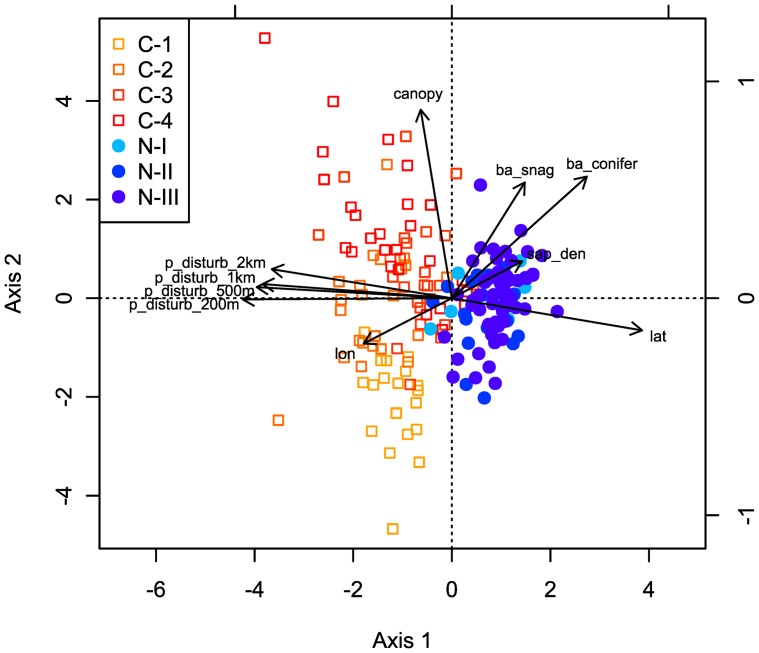
The positions of sampling sites in a constrained ordination space characterised by environmental variables.An arrow's length and its angle represent the strength of the correlation between the corresponding environmental variable and the first two ordination axes. The first axis of the constrained ordination diagram showed latitudinal transition of landscape-level disturbance gradients, and the second axis showed differences in canopy cover across successional gradient in post-clearcutting environment. Environmental variables: lon: longitude, lat: latitude, ba_conifer: basal area of conifer, canopy: canopy cover, sap_den: sapling density, ba_snag: basal area of snag, p_disturb_200 m: proportion of disturbed area at 200 m, p_disturb_500 m: proportion of disturbed area at 500 m, p_disturb_1 km: proportion of disturbed area at 1 km, p_disturb_2 km: proportion of disturbed area at 2 km. Age classes: C-1, C-2, C-3, and C-4: 5–19, 20–39, 40–59, and 60–70 year old clearcutting stands, respectively, N-I, N-II, and N-III: 50–79, 80–120, and >120 year old natural stands, respectively.